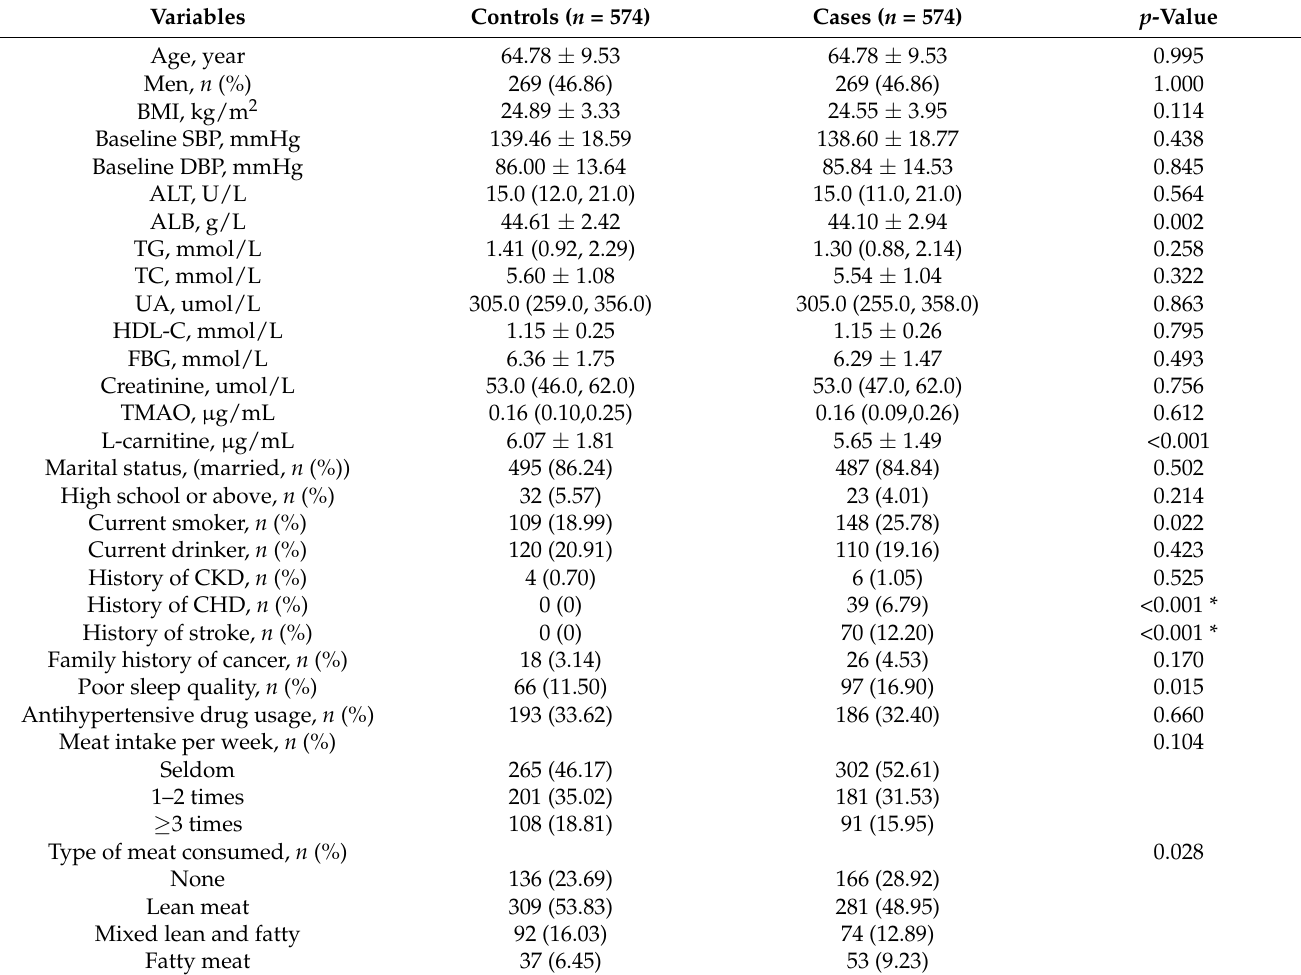
Table 1. Baseline characteristics of the cancer cases and matched